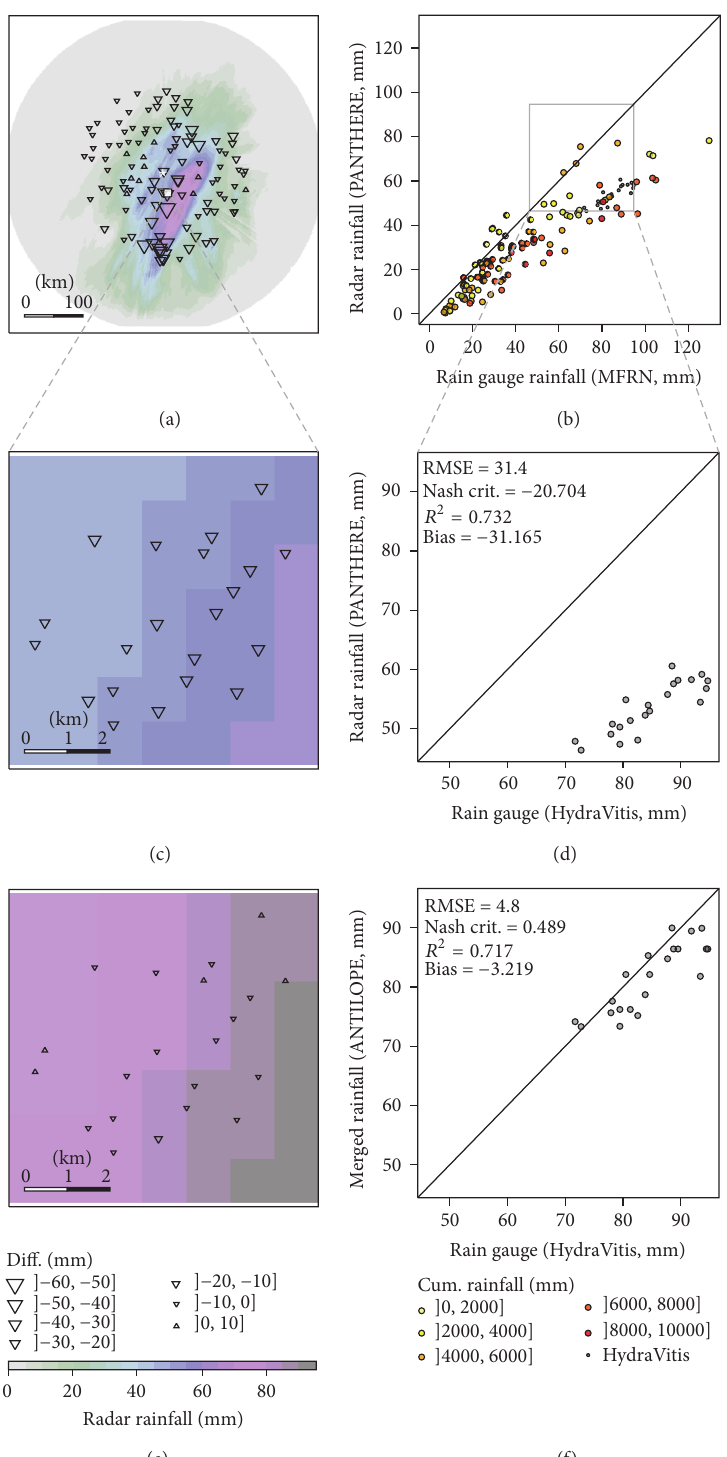
Figure 3: Comparison of 24-hour cumulated rainfall values from radar (PANTHERE) and rain gauges, from Nov. 3 at 21:00 to Nov. 4 at 20:00. (a)Radarrainfallmap.ThewhitestarindicatestheradarpositionandthewhitesquareindicatestheHydraVitisnetworkposition.Trianglesize (MFRN rain gauges) is proportional to the difference between values for radar and rain gauges; inverted triangles represent underestimated values; the regular triangles represent accurate or slightly overestimated values. (b) Scatterplot comparing PANTHERE to rain gauge rainfall data. Points are colored according to the rainfall summed for all pixels between the radar and each rain gauge (source of potential attenuation effect). (c) Zoom of (a) over the HydraVitis local scale rain gauge network. Triangle size (HydraVitis rain gauges) is proportional to the difference between values for radar and rain gauges. (d) Scatterplot comparing PANTHERE to rain gauge rainfall data. ((e) and (f)) The same as (c) and (d), respectively, but using the merged radar-based/MFRN rain gauge ANTILOPE data, instead of PANTHERE radar